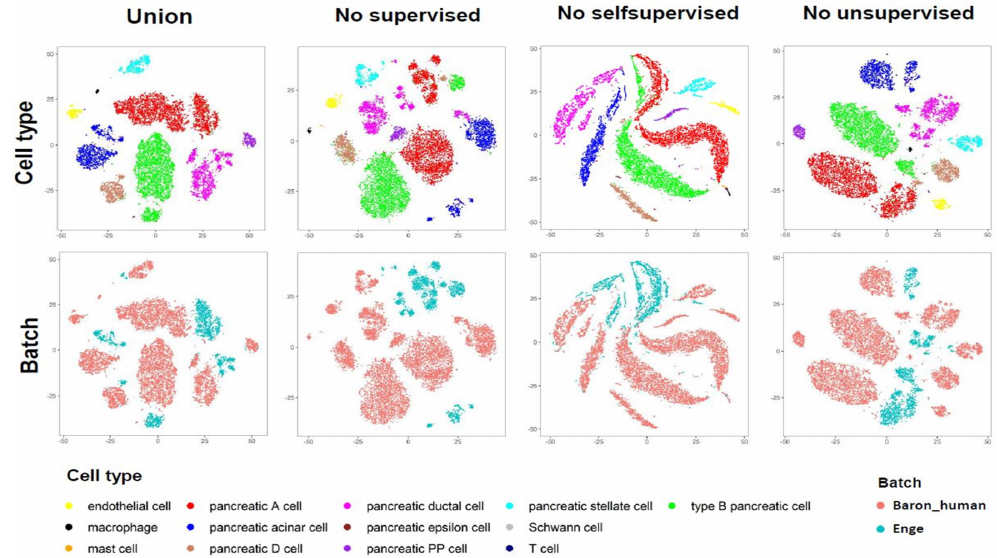
Figure 8. Visualization plots in 2D plane for scAnCluster in four groups of combining learning strategies on the “Baron_human+Enge” dataset.